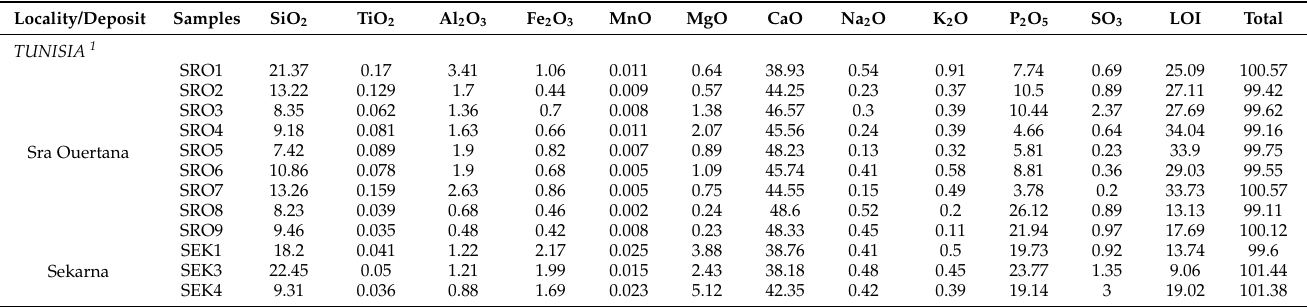
Table 1. Major elements composition (wt%) of the Paleocene–Eocene phosphorite deposits from Northern Africa. Locality/Deposit Samples